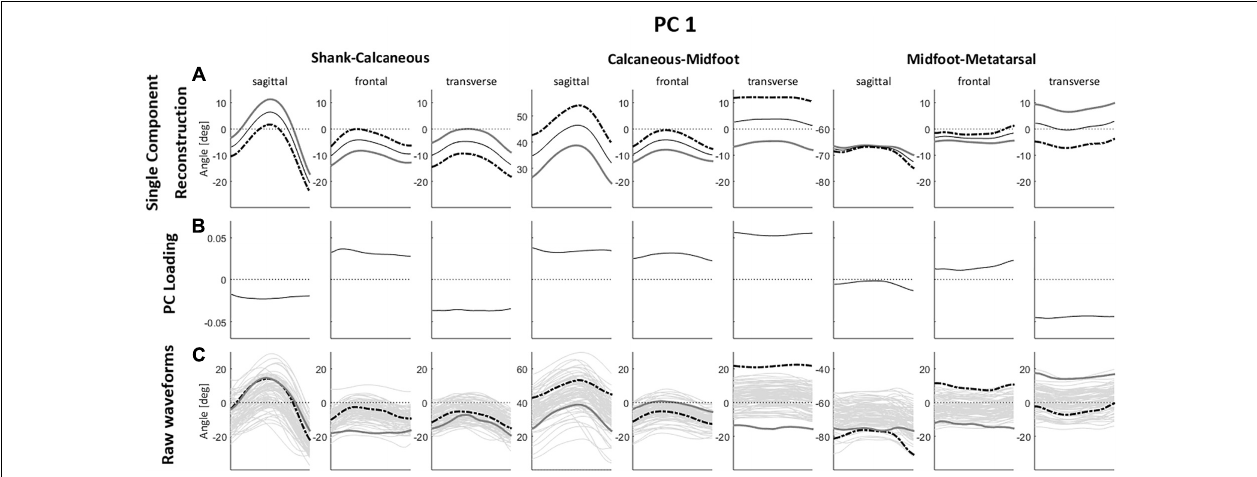
FIGURE 3 | (A) Single component reconstruction representing only the variance due to PC1 for the 5th (gray solid lines) and 95th (black dashed lines) percentile extreme representatives, and the mean reconstructed waveform (thin black solid lines); (B) PC loading vector with the pattern of variance captured by PC1; (C) raw waveforms for the 5th (gray solid lines) and 95th (black dashed lines) percentile extreme representatives for PC1, superimposed on all raw waveforms (thin gray solid lines). Positive (+) and negative (–) joint angles represent the following – sagittal plane: (+) dorsiflexion, (–) plantar flexion; frontal plane: (+) eversion, (–) inversion; transverse plane: (+) abduction, (–) adduction.